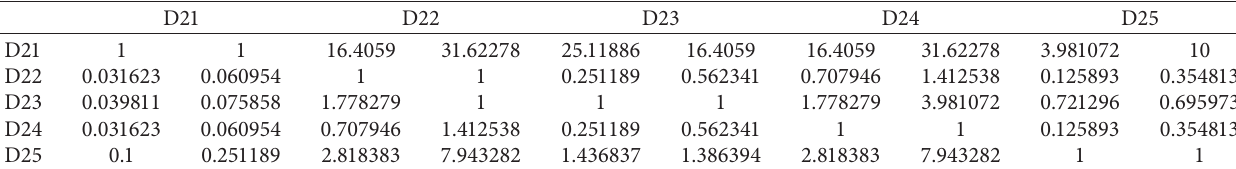
Table 7: Difference matrix.